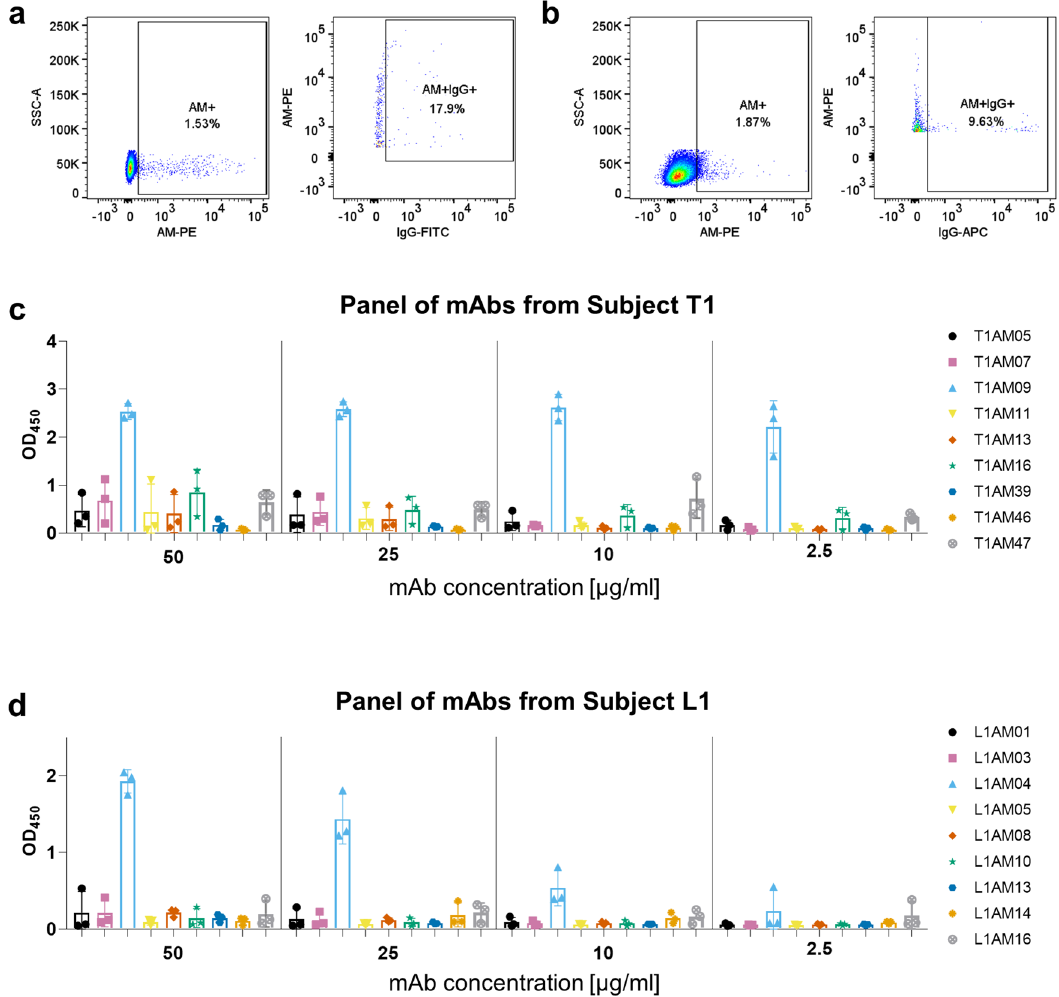
Fig. 1 Human B cells and monoclonal antibodies (mAbs) bind with ranging af fi nities to arabinomannan (AM). Binding of human B cells to AM by fl ow cytometry for a subject T1 (CD20 + , CD27 + , IgG + ), b subject L1 (CD19 + , IgG + ). Binding of mAbs to H37Rv AM by ELISA at varying concentrations from c subject T1, and d subject L1. Florescence-minus-one (FMO) controls were used to set conservative AM + gates and IgG + gates for sorting. Each bar represents the mean and standard deviation from three